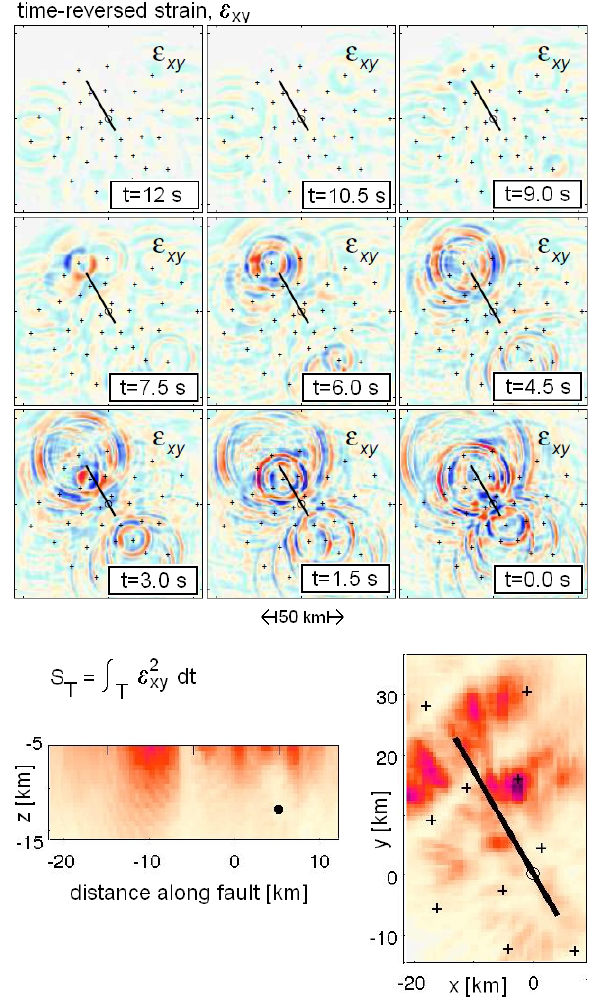
Fig. 7. Top: Snapshots of the time-reversed strain component (cid:15) xy at 12 . 5km depth. The fault trace is indicated by the black line. All snapshots are shown in the same amplitude range. Bottom: Cumu- (cid:15) 2 xy dt plotted on the fault plane (left) lative squared strain S T = R T and integrated over depth